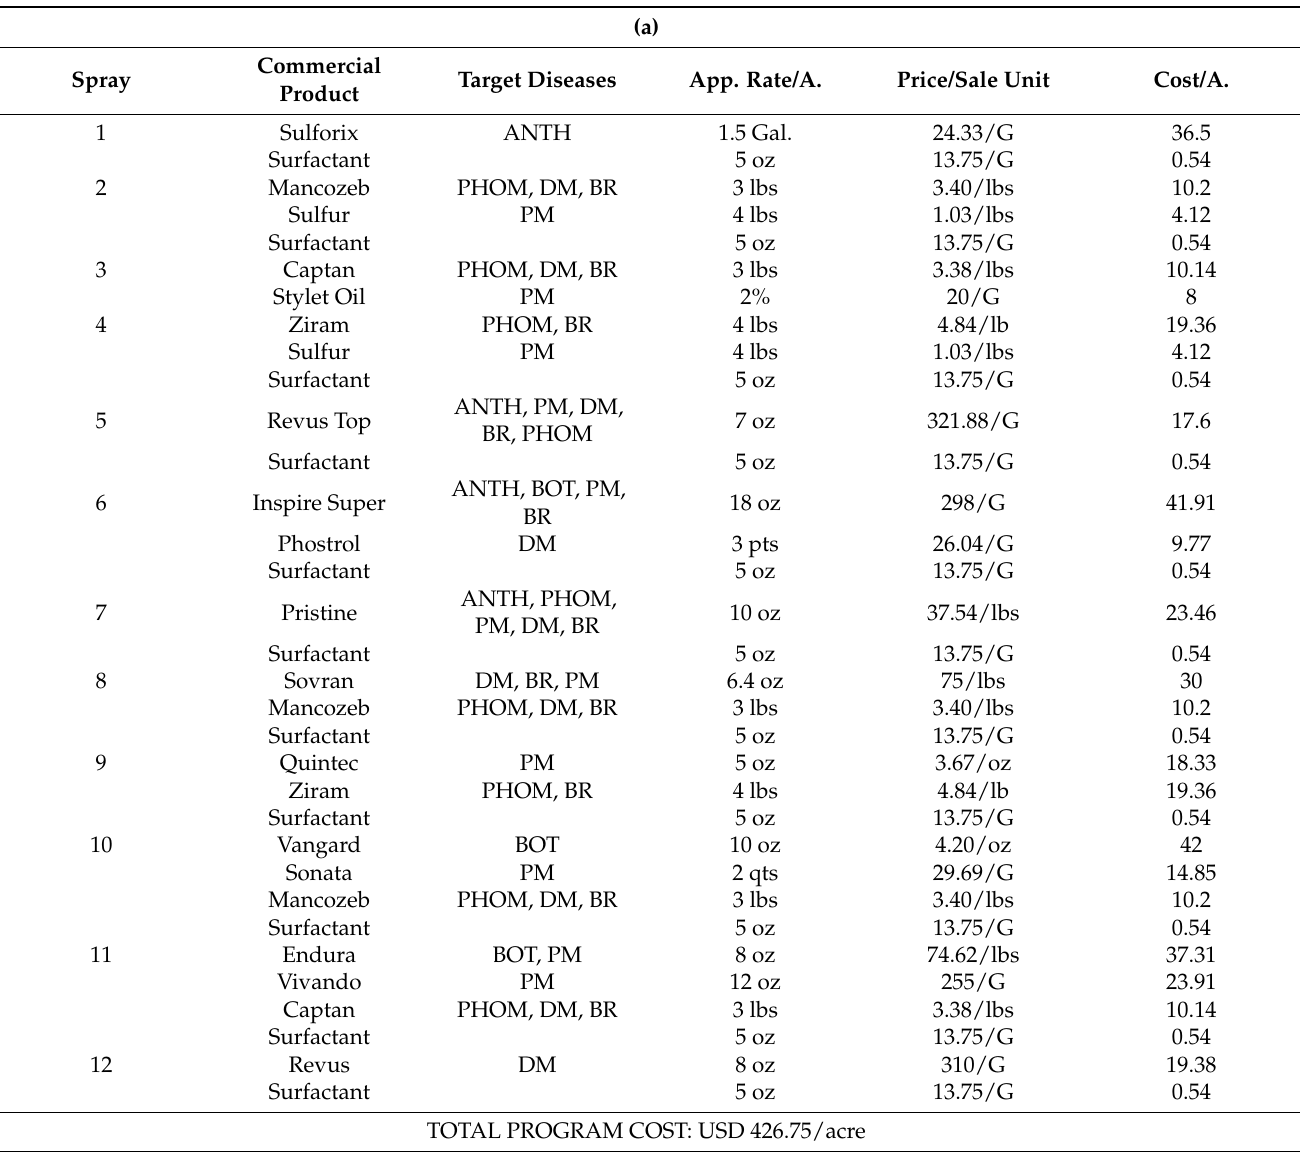
Table 2. ( a ) Fungicide program considered in the sample budget of a 10-acre Marquette vineyard, for productive years only (from year 4 on). ( b ) Insecticide program used for productive years in the budget of a hybrid